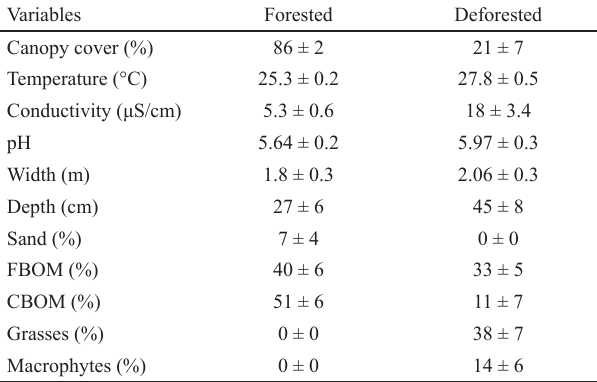
Tab. 1. Values of mean ± standard error for the variables measured in the habitat characterization of forest and deforested first-order stream reaches in the Upper Xingu River Basin. FBOM = fine benthic organic matter; CBOM = coarse benthic organic